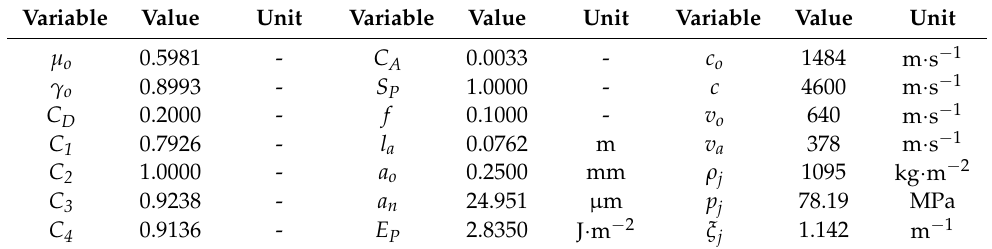
Table 1. Variables determined for the tested configuration of the injection abrasive water jet.